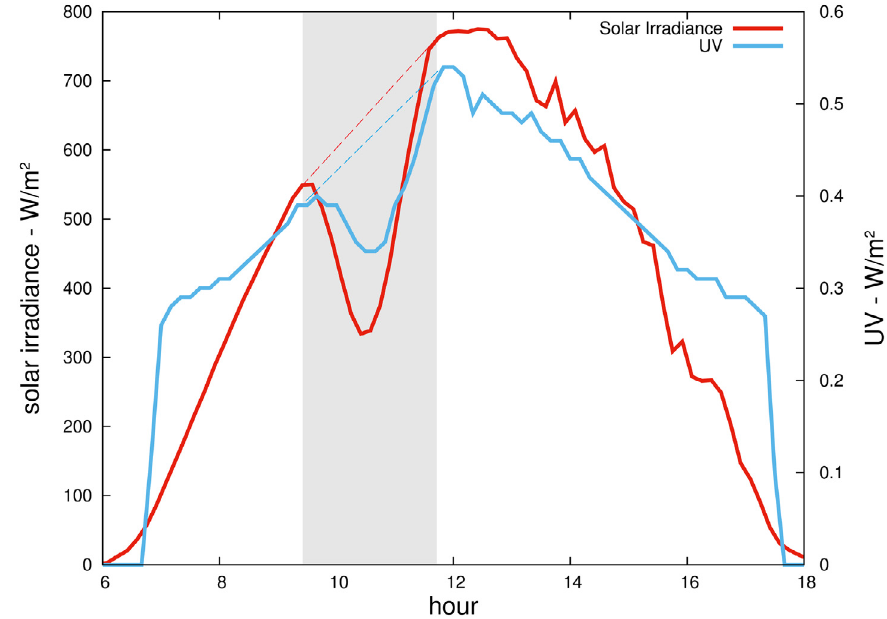
Figure 5. Total solar irradiance and UV irradiance measured in Naples on March 20, 2015. The colored area highlights the period from 9:25 to 11:43 (UT+1, local time) when the eclipse occurred in Naples: see Table 1. The blue and red broken lines show approximately the expected normal behavior of the UV and solar irradiance at the same day without